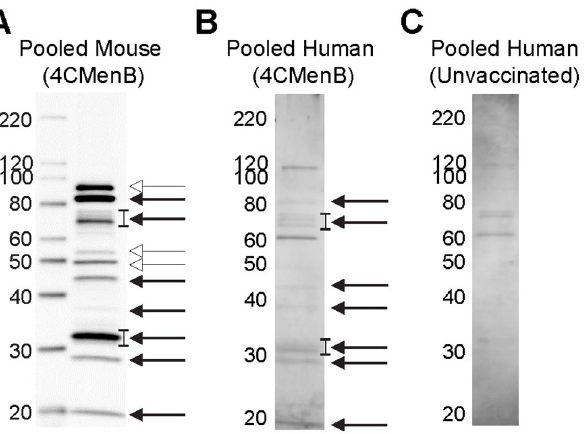
Fig 7. Comparison of pooled serum from 4CMenB-immunized mice and humans for cross-reactivity against Ng OMV proteins. The reactivity of pooled serum from 4CMenB-immunized mice and humans was tested for recognition of Ng strain F62 OMV proteins by western blot. Pooled serum from unvaccinated humans was tested in parallel. Mouse antiserum was collected 10 days after the third 4CMenB immunization; human subjects were immunized with 4CMenB two times and the sera were collected between 2 and 15 months after the second immunization as described in the Methods. (A) Pooled mouse serum from 4CMenB-immunized mice, 1:10,000 dilution; (B) pooled serum from 4CMenB-immunized persons, 1:500; (C) pooled serum from unimmunized persons, 1:500. Bands of similar molecular weight that were detected by both immunized murine and human sera are indicated by the solid arrow; bands that were detected only by mouse sera are indicated by the open arrow heads. The lowest band indicated by the open arrowheads is MtrE. The faint band under the 40 kD marker indicated by the solid arrow is consistent with the apparent molecular weight of PorB. The ~ 20 kD band that is recognized by both human and mouse serum is similar in apparent molecular weight to a band that was strongly recognized by serum from a 4CMenB-immunized individual in Semchenko et al . [30]. A band of this molecular weight was also intensely recognized by IgG and IgA in vaginal washes from 4CMenB-immunized mice (Fig 4B).